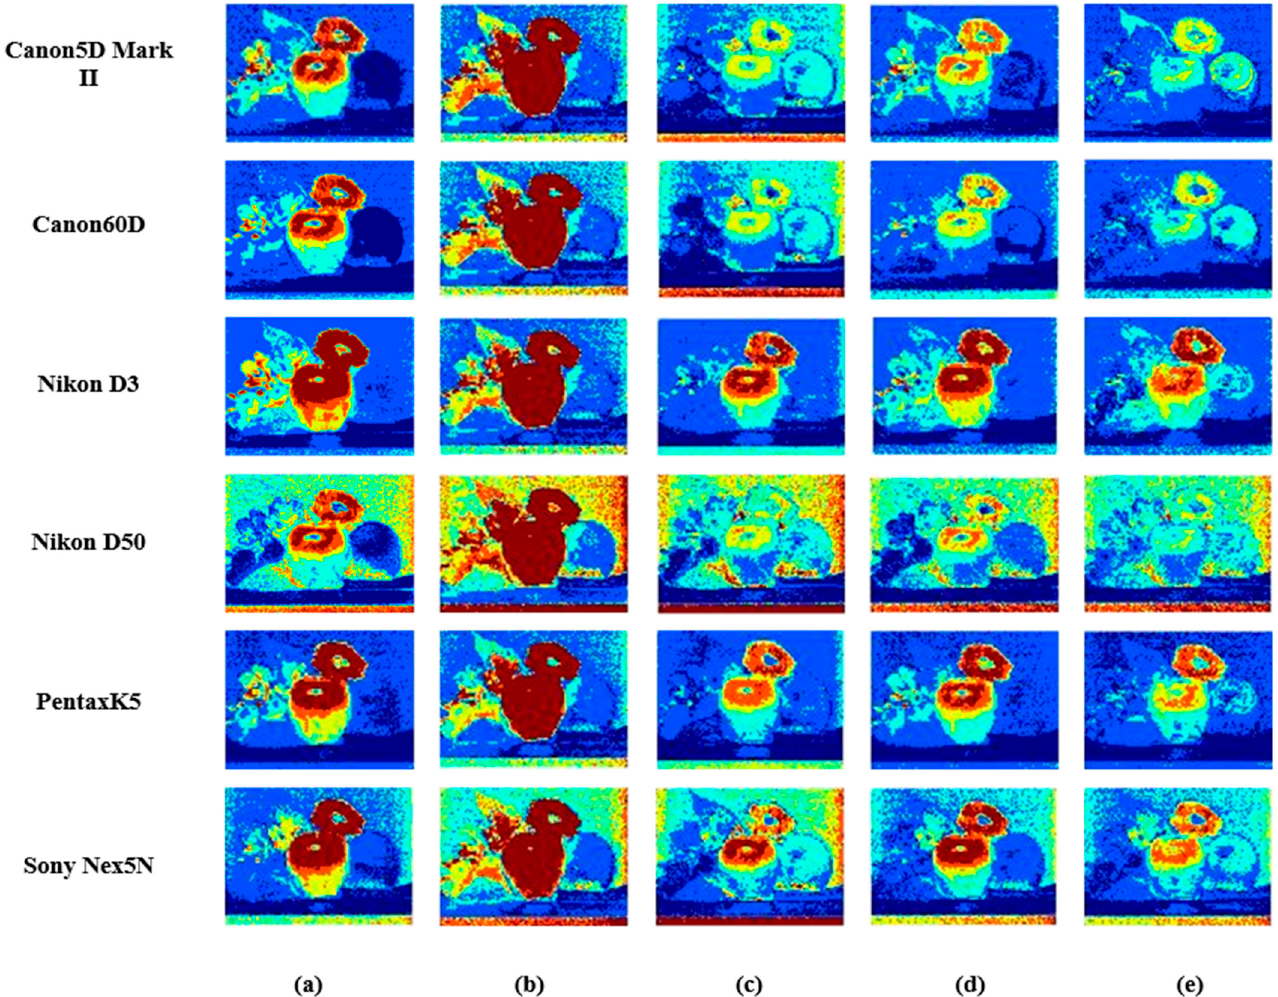
Figure 13. Results comparison of fruit spectral images in different methods using six spectral sensitivity functions as the spectral sensitivity: ( a ) PI, ( b ) PCA, ( c ) Wang [37], ( d ) Zhang [32] and ( e ) the proposed.